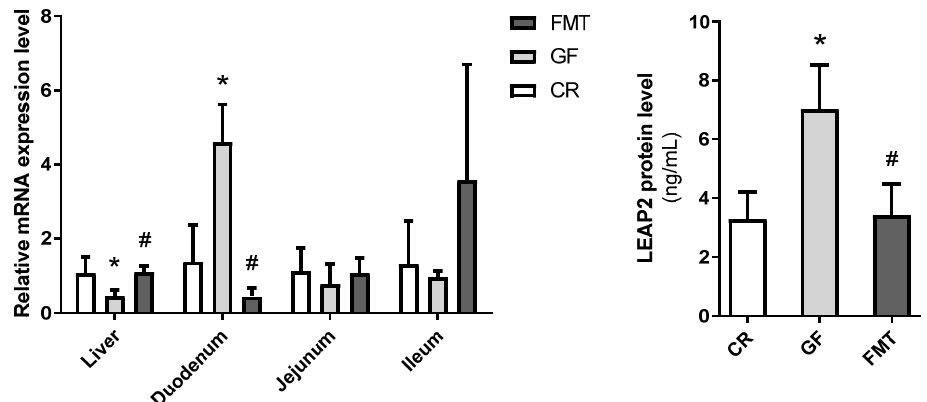
Figure 2. Leap2 expression in germ-free male mice after a fecal microbiota transfer. Relative Leap2 gene expression was measured by qPCR ( left ) in the liver and small intestinal regions and LEAP2 protein levels ( right ; ng/mL) were measured in the plasma by ELISA of 13 week-old conventionally raised (CR) (n = 10), GF (n = 5) and in GF mice after fecal microbiota transfer (FMT) (n = 6). Relative mRNA expression is plotted relative to CR mice for each tissue. Plots represent means ± S.D. Post-hoc analysis was carried out between GF and CR mice to determine the impact of the lack of microbiota or GF and FMT mice to determine the impact of the introduction of microbiota. * GF vs. CR; # FMT vs. GF. * p ≤ 0.05, # p ≤ 0.05.